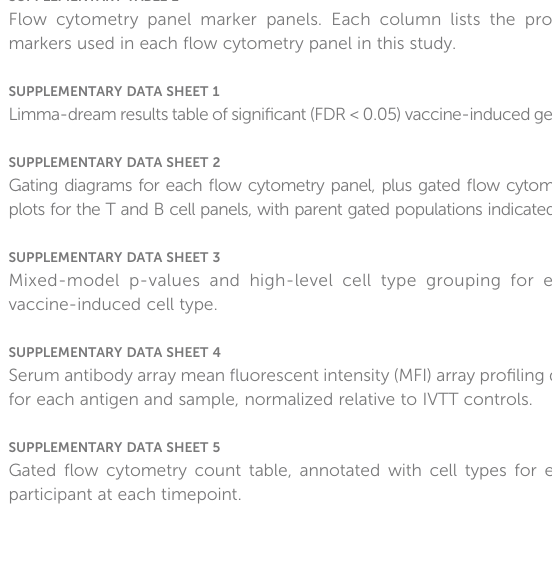
SUPPLEMENTARY TABLE 1 Flow cytometry panel marker panels. Each column lists the protein markers used in each fl ow cytometry panel in this